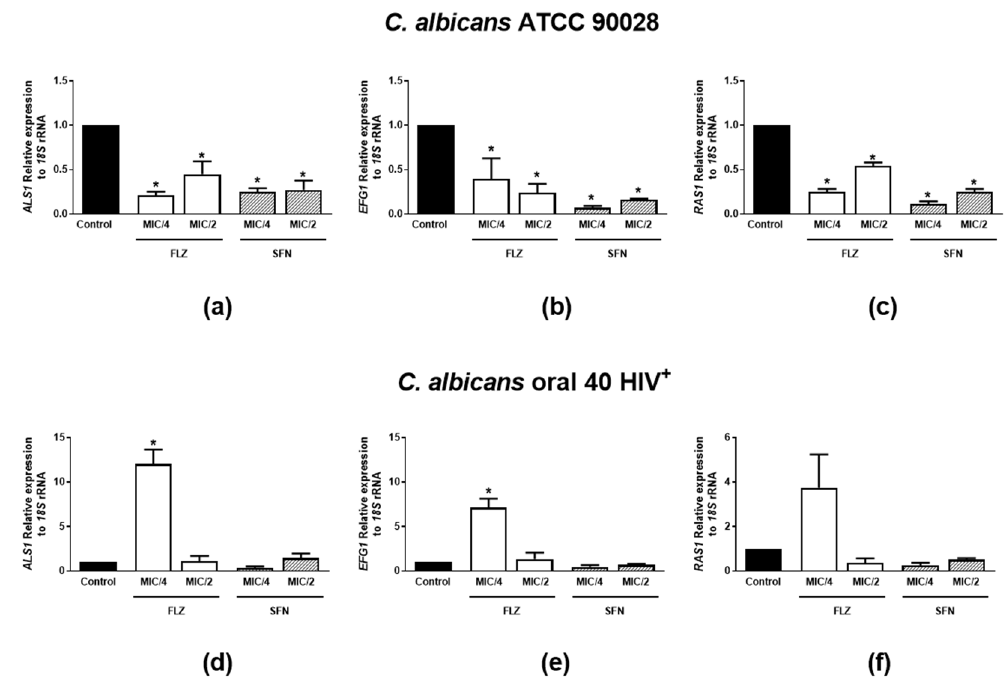
Figure 4. Effects of sulforaphane (SFN) and fluconazole (FLZ) on mRNA expression of hyphae growth- and biofilm formation-related genes by C. albicans spp. SFN and FLZ were tested at MIC/2 and MIC/4 against C. albicans ATCC 90028 and the oral isolate 40 HIV + . The relative expressions of ALS1 ( a , d ), EFG1 ( b , e ) and RAS1 ( c , f ) normalized to 18S rRNA were quantified 24 h following incubation with either FLZ or SFN. The control consisted of inoculum plus culture medium. Data were obtained from three independent experiments and are depicted as relative expression of mRNA. * p < 0.05 differs from the control group.